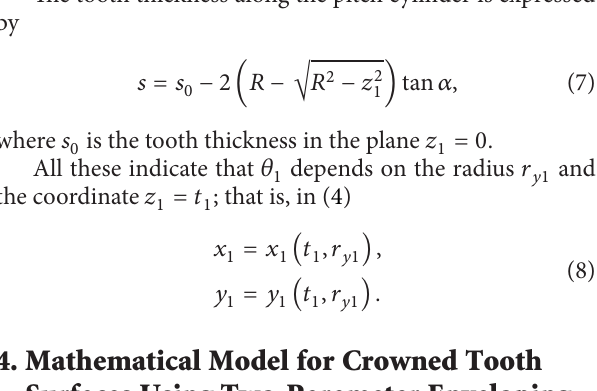
Figure 5: Applied coordinate systems and axes of